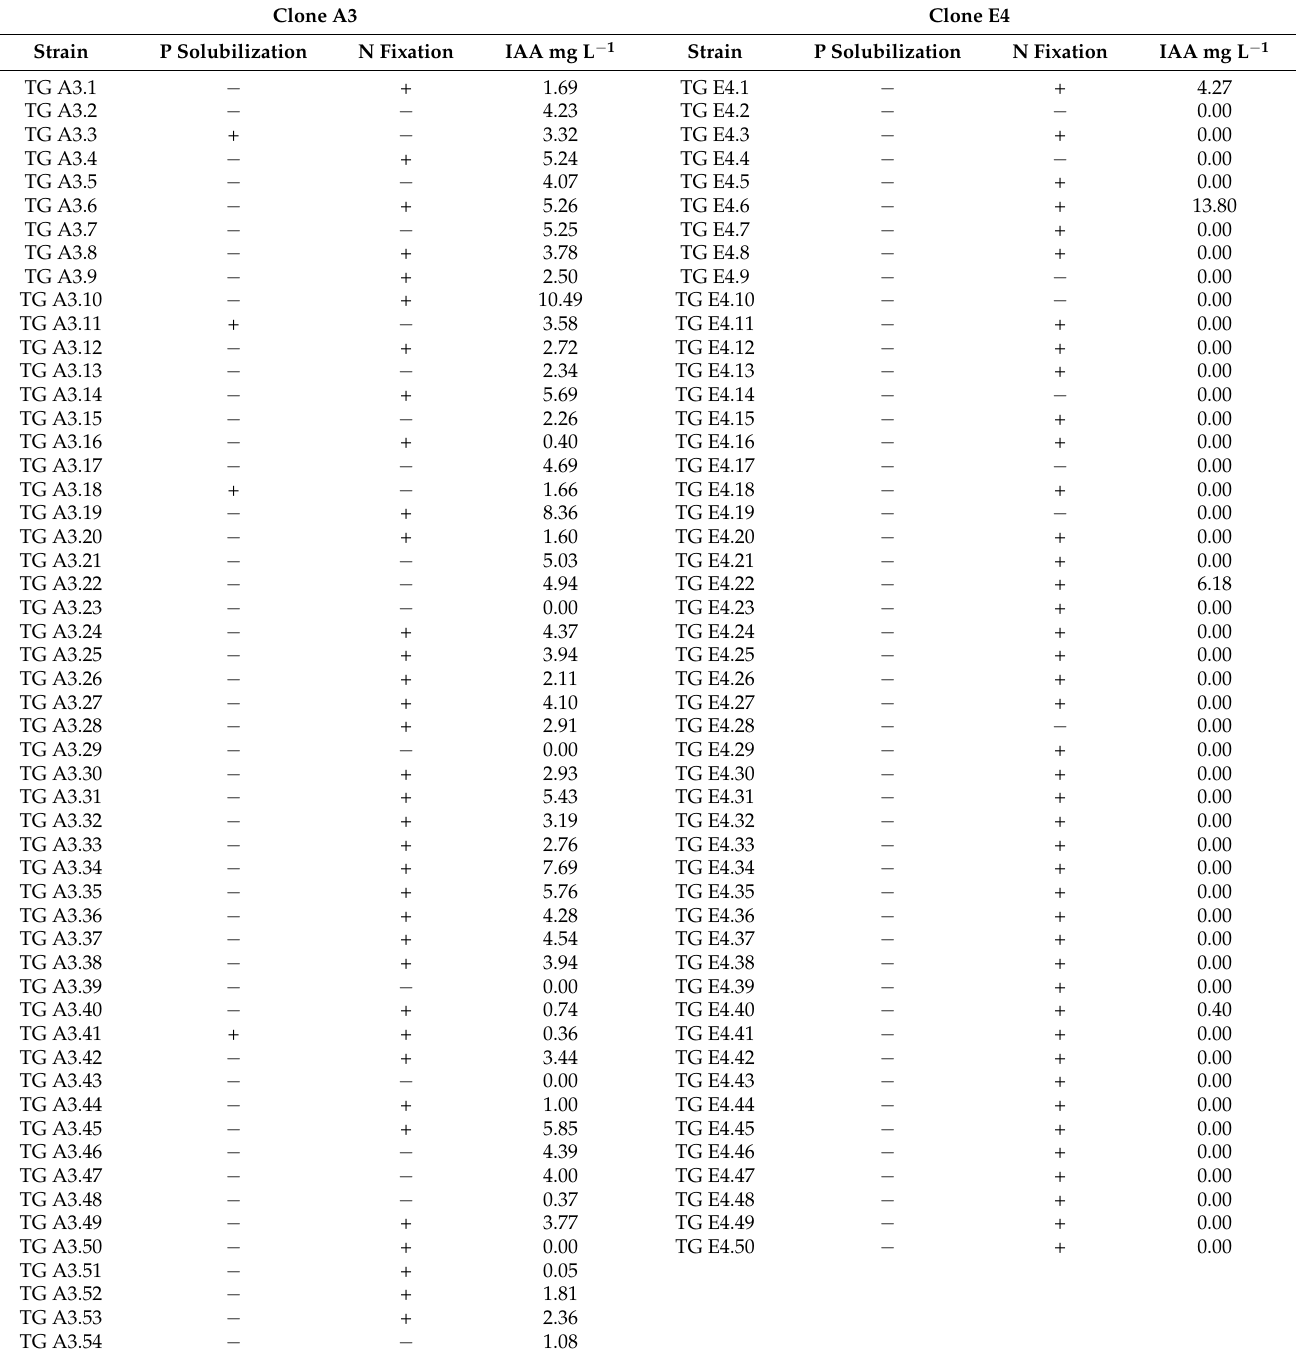
Table 3. Characterization of endophytic bacteria according to PGP traits, phosphorous (P) solubiliza- tion, nitrogen (N) fixation, and indol-acetic acid (IAA)